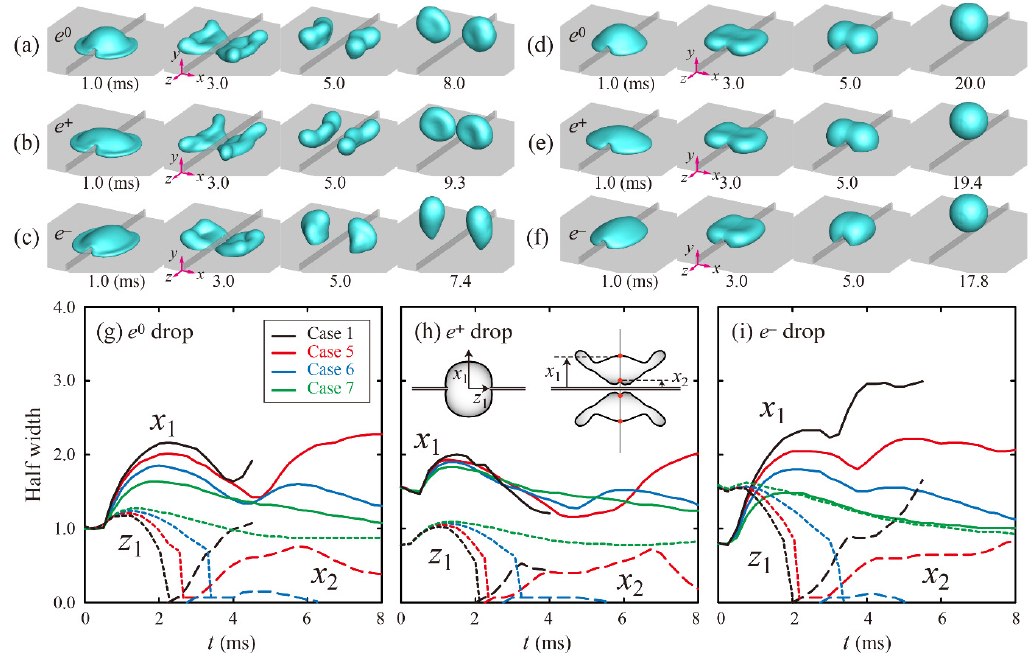
Figure 4. Snapshots of water/glycerin mixtures of ( a – c ) 60 wt.% (Case 5) and ( d – f ) 85 wt.% (Case 7) at U = 1.3 m/s. ( g – i ) Temporal variations in dimensionless half widths of e 0 , e + , and e − drops for Case 1 and Cases 5–7 until drops rebound from the surface and ridge.